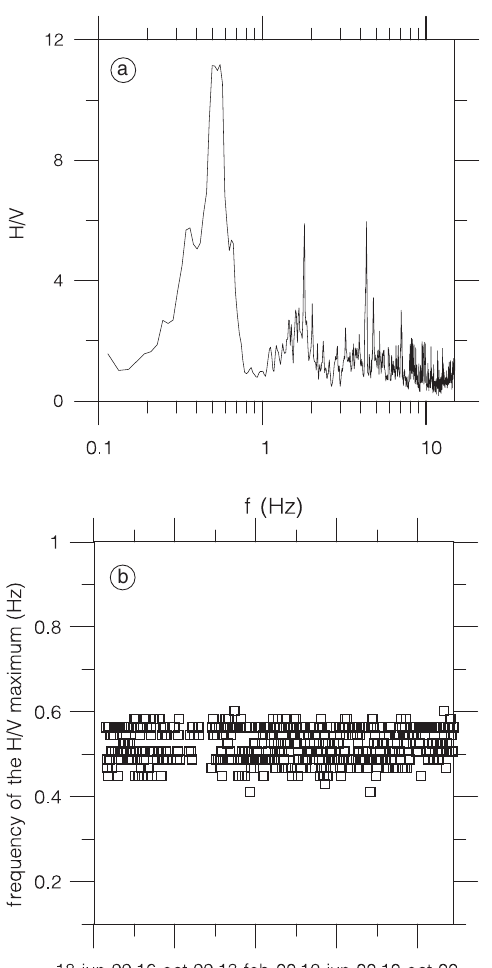
Fig. 11a,b. a) Horizontal to vertical component (H/V) spectral ratio for 1 h noise samples at 3 AM local time on 30th January 2000; b) frequency of the maximum H/V spectral ratio for all the analyzed noise samples from 18th June 1999 to 14th November